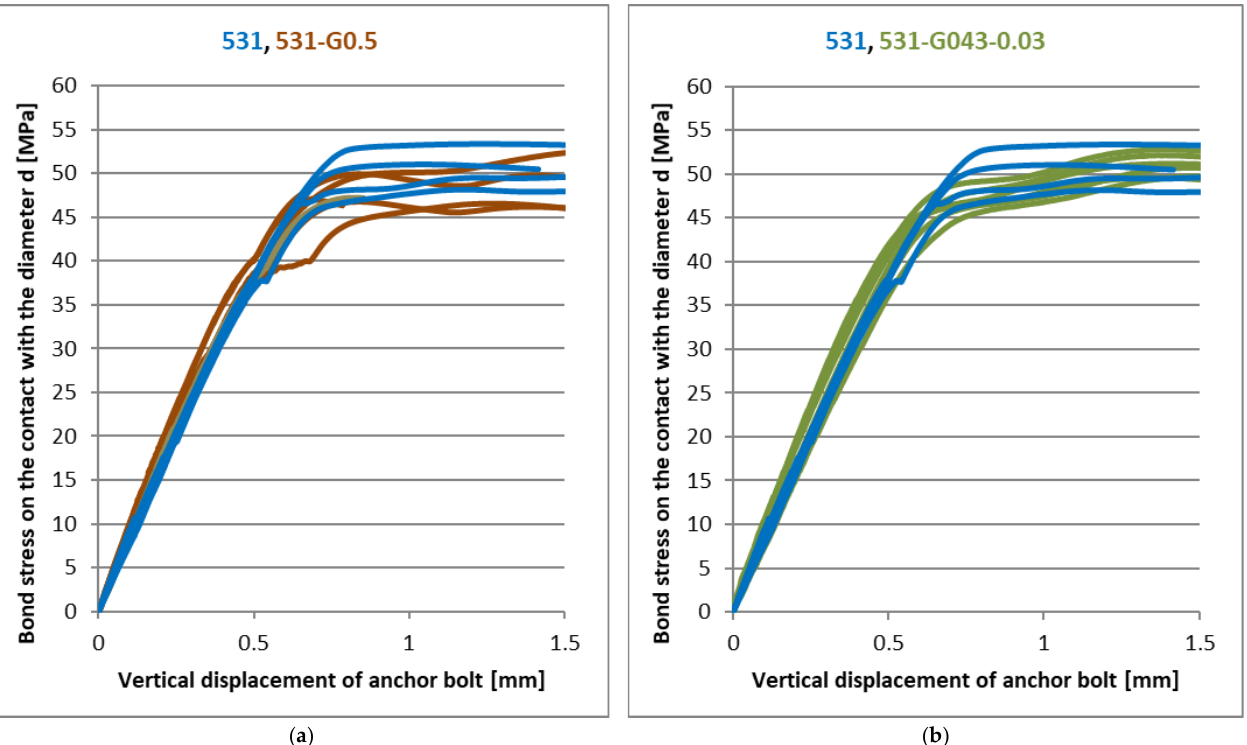
Figure 12. ( a ) The effect of the graphene oxide on CHS Epoxy 531 ( a ) GO21 — 0.5 phr; ( b ) GO43 — 0.03 phr.